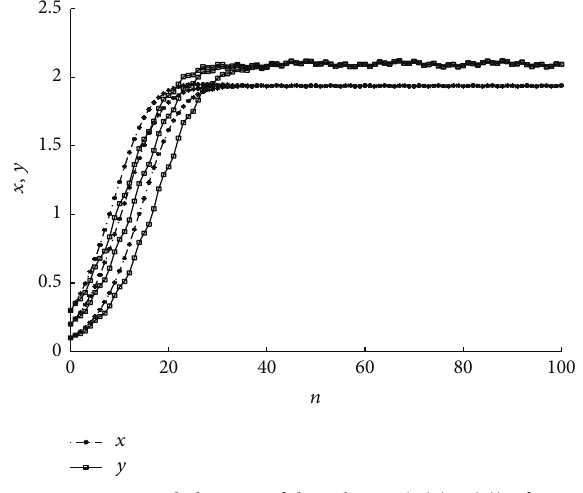
Figure 1: Dynamic behaviors of the solution (𝑥(𝑛),𝑦(𝑛)) of system (2) with initial conditions (𝜑(𝜃),𝜓(𝜃)) = (0.1, 0.3),(0.3, 0.1), (0.2, 0.3) for 𝜃 = −2,−1, 0 ,